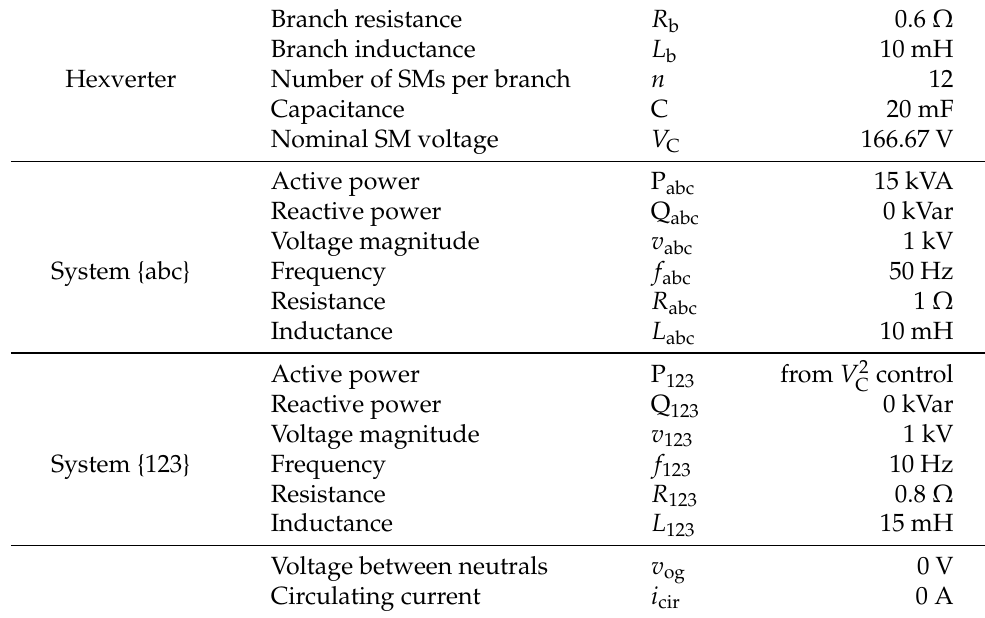
Table 1. Simulation